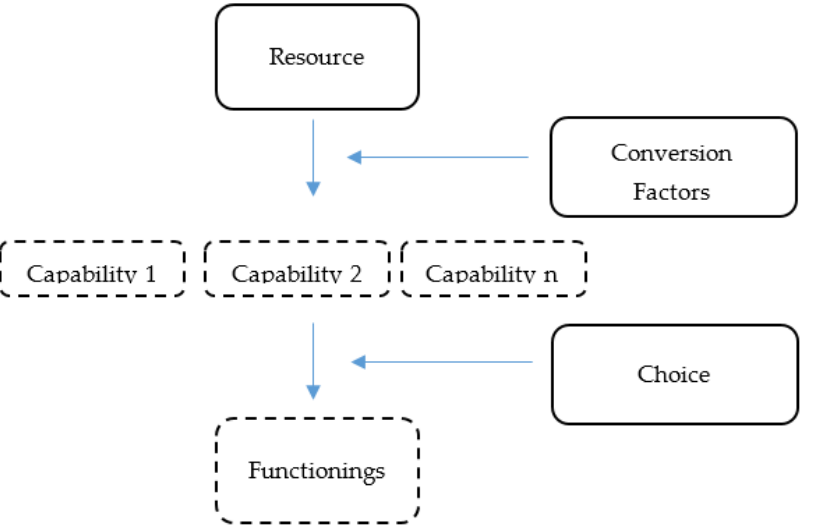
Figure 1. Amartya Sen’s Capability Approach Framework.